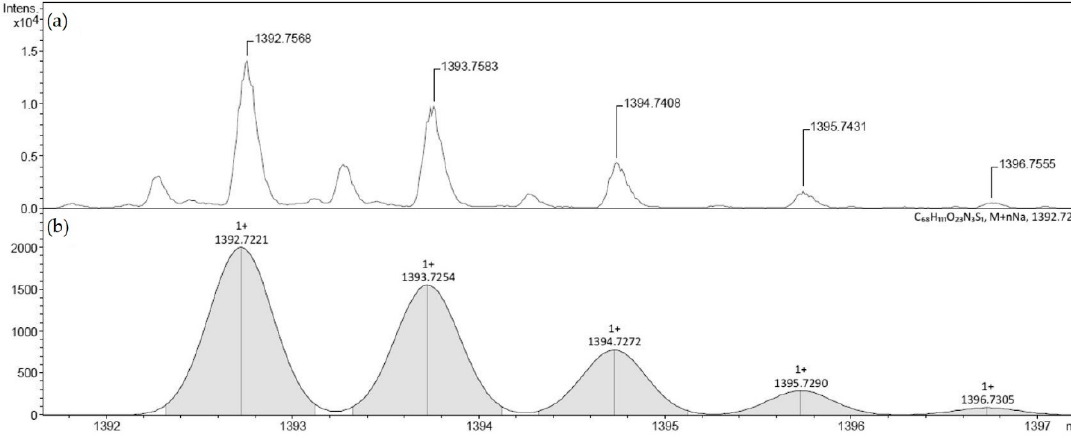
Figure 3. Isotopic distribution for positively charged conjugate coupled with sodium ion ( a ) and spectra simulation of conjugate composed of ten subunits, and drug molecule with singular sodium adduct ( b ).